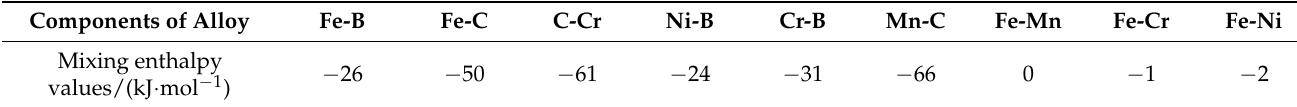
Table 7. Mixing enthalpy values of atomic